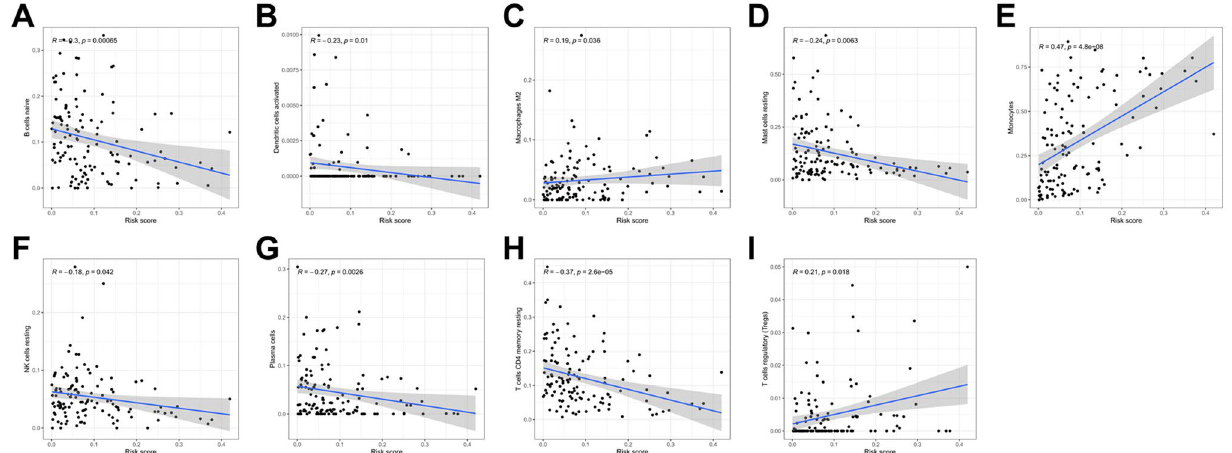
Figure 11. Correlation between risk scores and levels of immune cell infiltration in AML. Notes: immune cells included naïve B cells ( A ), activated dendritic cells ( B ), M2 macrophages ( C ), resting mast cells ( D ), monocytes